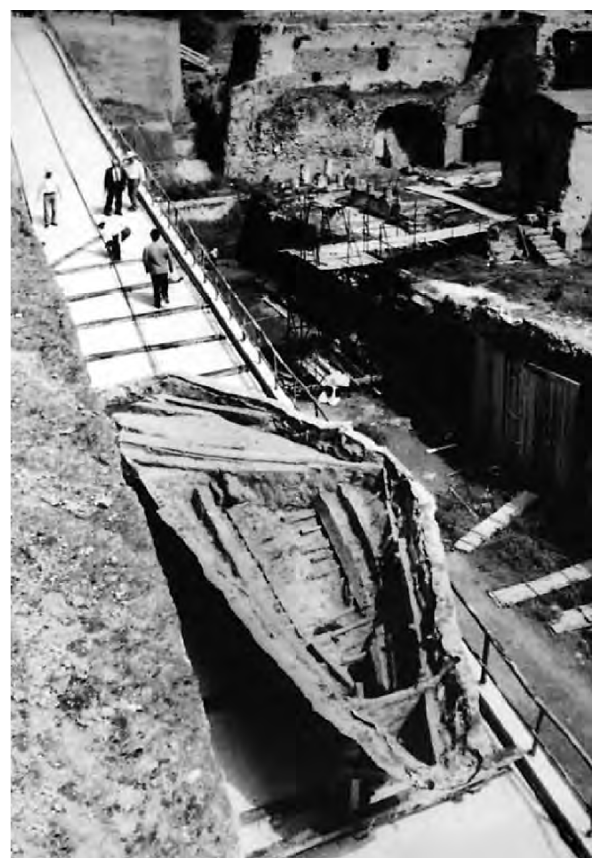
Figure 1. The carriage of the boat at the moment of discovering (from Camardo et alii ,